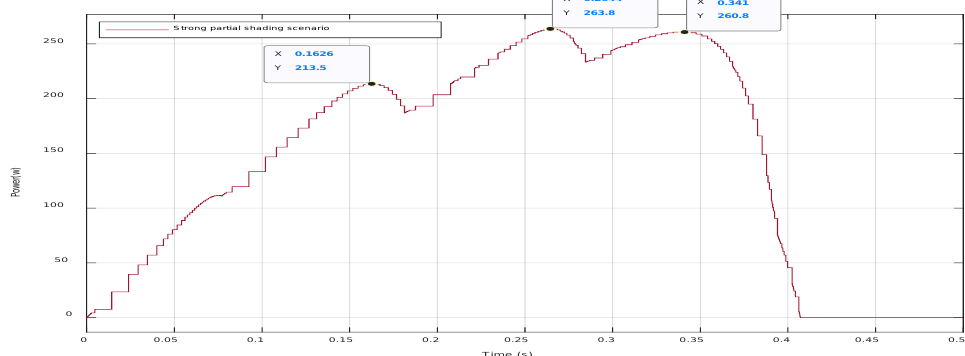
Figure 13. Scenario of Case Four (Strong partial shading pattern)